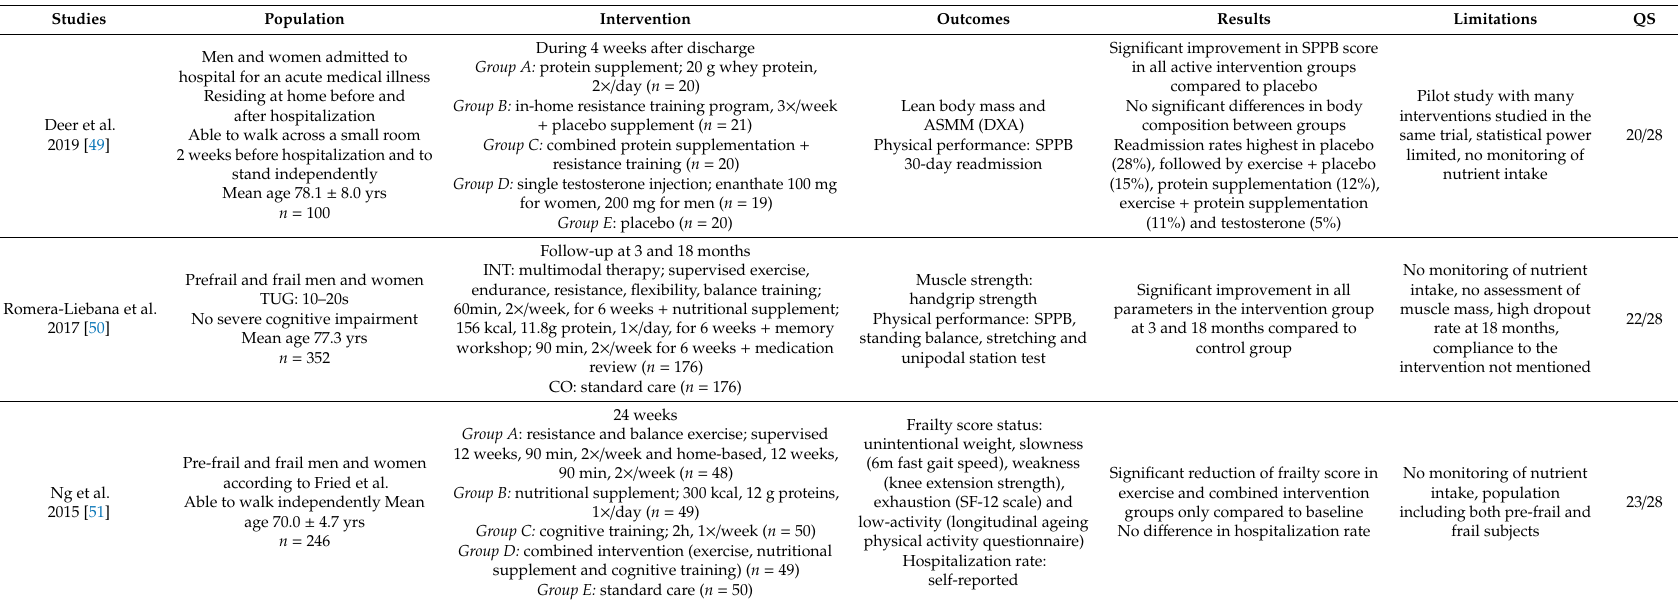
Table 4. Multimodal interventions in community-dwelling older